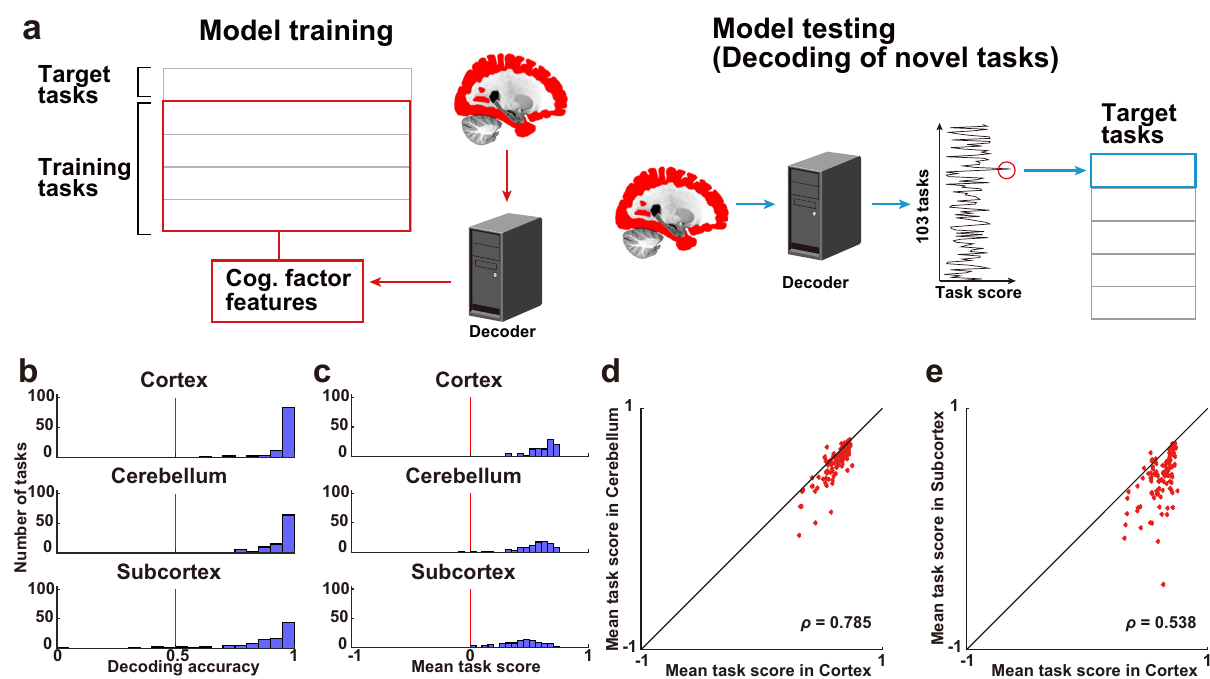
Fig. 5 Decoding novel tasks. a The decoding model was constructed using 80% of the tasks in the training dataset and applied to the 20% left-out tasks in the test dataset using brain activity with hemodynamic temporal delays. The decoding accuracy was examined by calculating task score for each target time point. b Histogram of task decoding accuracies for subject ID01, using a binary classi fi cation (Supplementary Fig. 7 show the other subjects). The red line indicates the chance-level accuracy (0.5). Filled bars indicate tasks that were decoded with signi fi cant accuracy (one-sided sign test, n = 102, P < 0.05, FDR-corrected). c Histogram of task decoding accuracies represented by average task score ( n = 715). The red line indicates the chance-level accuracy (0). d – e Scatter plot of the task score of decoded tasks for 103 tasks by d the cortex and cerebellum models and e the cortex and subcortex models ( n =